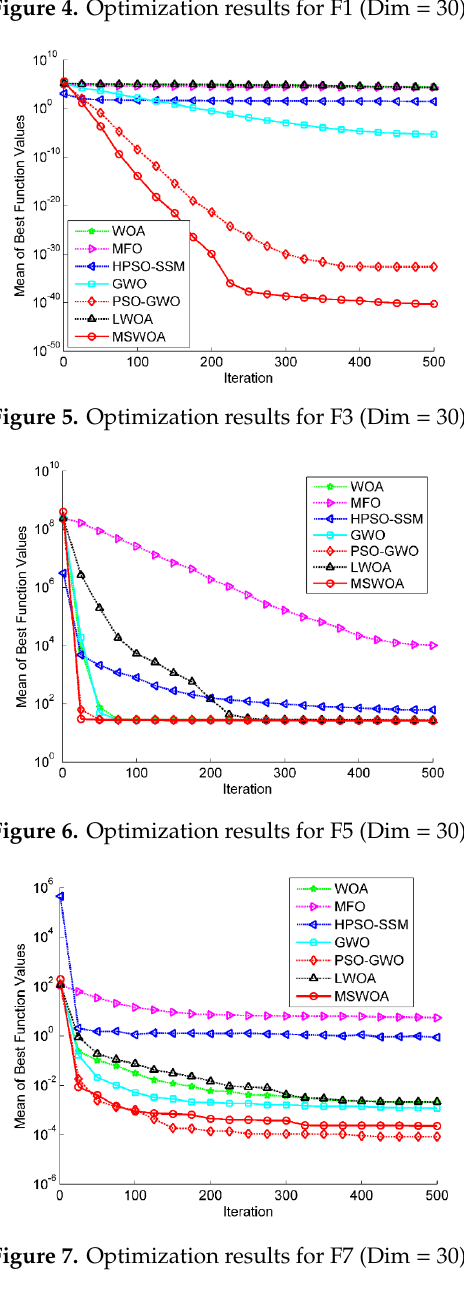
Figure 7. Optimization results for F7 (Dim = 30).